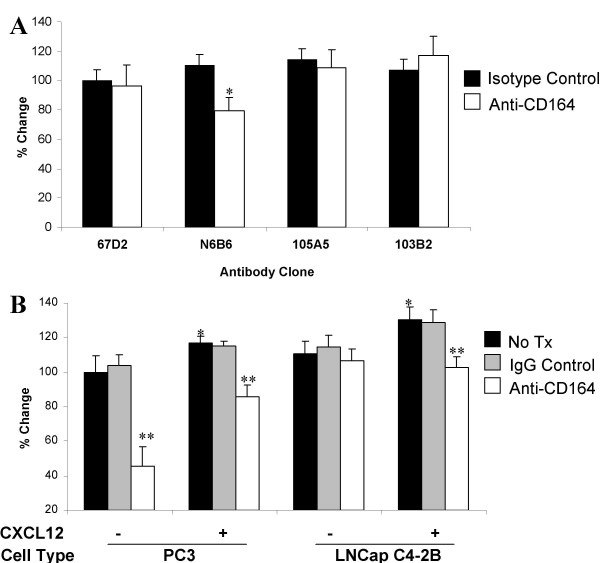
CD164 regulates CaP cell adhesion to HBME. PC3 and LNCaP C4-2B cells were labeled with Vybrant CFDA SE Cell Tracer Kit, (Molecular Probes, Inc., Eugene, Oregon) for 30 min and directly deposited on to human bone marrow derived endothelial (HBME) monolayers. CXCL12 pretreatment was performed by incubating the CaP cells with 200 ng/ml CXCL12 for 2 hours. In (A) 50 μg/mL anti-CD164 mAb antibodies (or Ig controls) were added to each chamber. Cell-to-cell adhesion for PC3 cells was preformed for 30 min at 37°C and quantified using a 96-well fluorescent plate reader (IDEXX Research Products, Westbrook, ME). Data are presented as percent change +/- standard deviation from non-treated controls for n = 4. In (B) the CD164 antibody (N6B6) was used in an adhesion assay with PC3 and LNCaP C4-2B cells treated with either PBS or CXCL12 (200 ng/ml) to block adhesion. * Indicates significant difference from vehicle treated cells (no CXCL12), and ** indicates significant difference from Ig treated controls at p < 0.05. The data demonstrates that CD164 blockade regulates PC3 and LNCaP C4-2B binding to HBME.